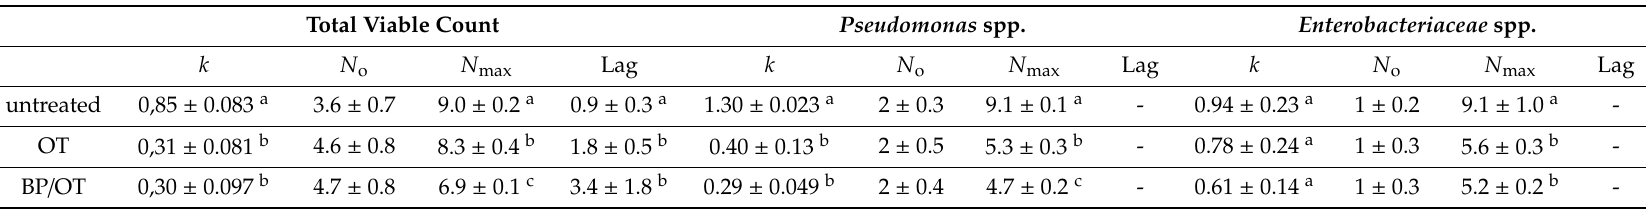
Table 1. Growth rates ( k in days − 1 ), initial ( N o in log cfu / g) and final population ( N max in log cfu / g), and lag phase (Lag in days) of total viable count, Pseudomonas spp. and Enterobacteriaceae spp. of sea bass slices stored at 5 ◦ C